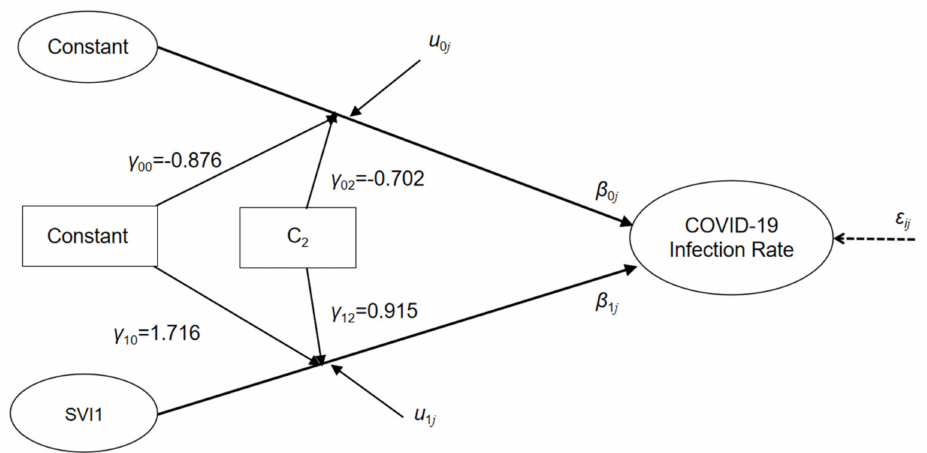
Figure 3. Interaction of the cross-layer self-variable through the return